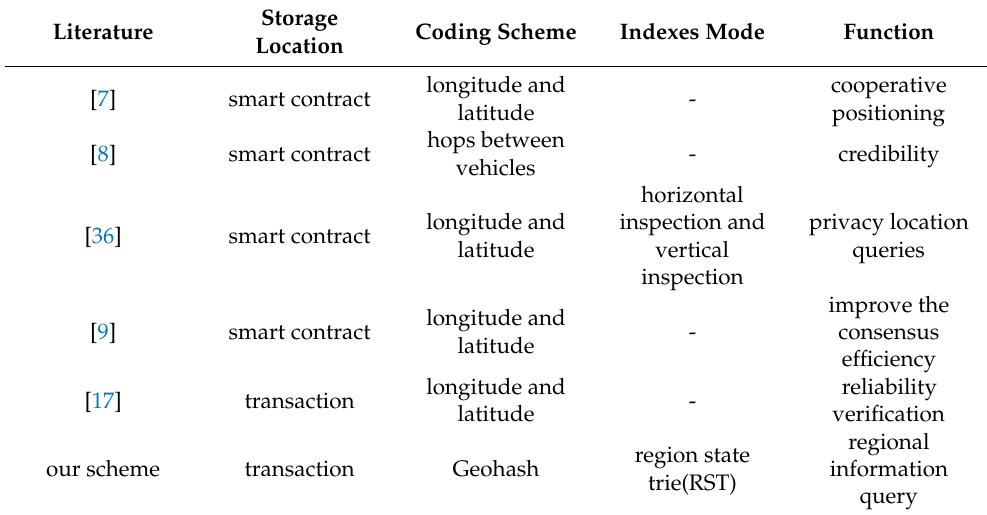
Table 1. Comparison between our scheme and the technical schemes related to geolocation and